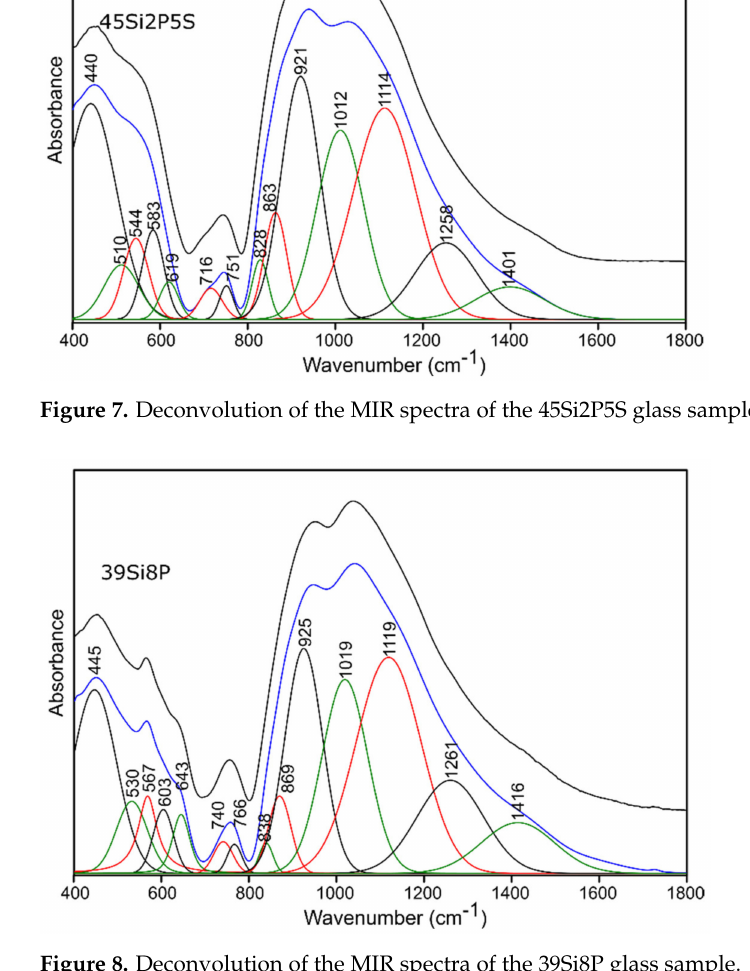
Figure 8. Deconvolution of the MIR spectra of the 39Si8P glass